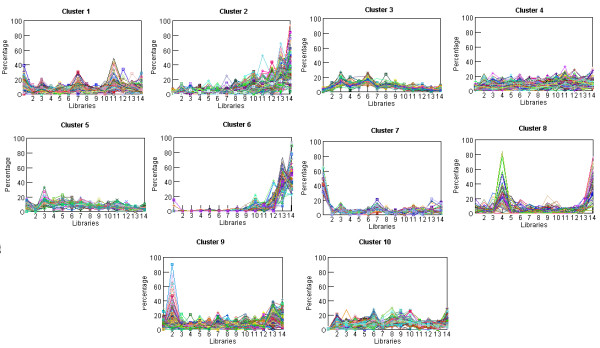
Poisson model-based clustering analysis for photoreceptor gene expression using 10 clusters. SAGE libraries are plotted on the x-axis. Numbers one to fourteen represent the fourteen SAGE libraries mentioned in Method Section, i.e. 1: hypo; 2: 3t3; 3: E12.5; 4: 14.5; 5: E16.5; 6: E18.5; 7: P0.5; 8: P2.5; 9: P4.5; 10: P6.5; 11: P10.5Crx-/-; 12: P10.5Crx+/+; 13: Adult; 14: ONL. Tag abundance is shown on the y-axis. Data were normalized before plotting. Each tag from the 14 libraries was rescaled to make the sum of the expression values equal to one. Different colors represent different tags.